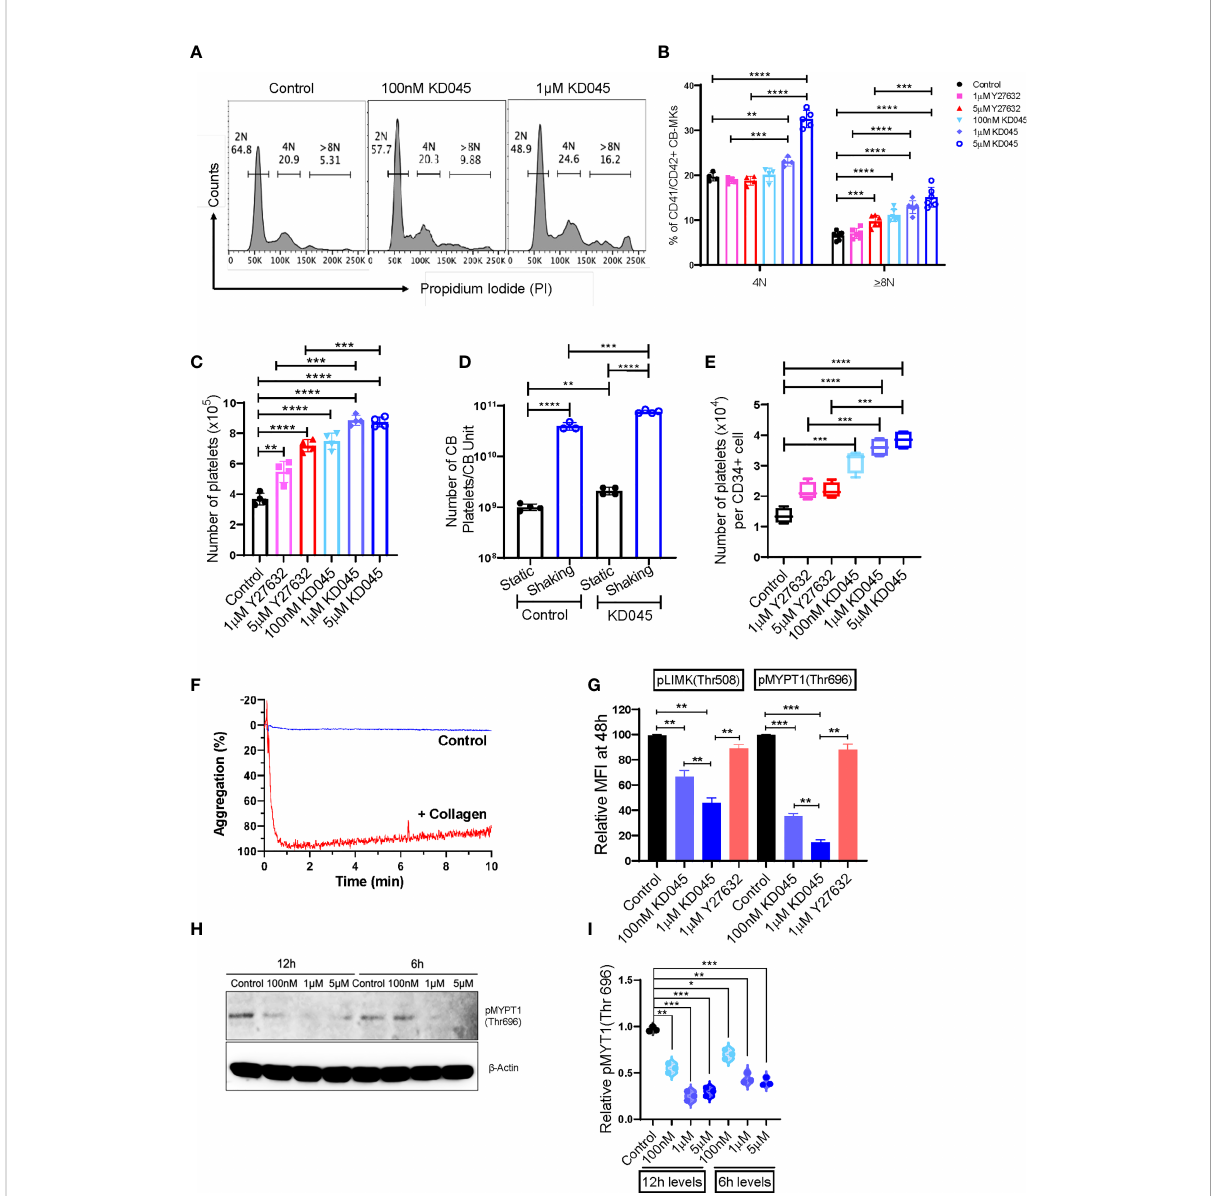
FIGURE 3 KD045 ex-vivo treatment enhances CB-MK polyploidization, reduces ROCK signaling, and stimulates MKs to secrete more functional platelets. (A) Histograms showing ploidy analysis by propidium iodide (PI) staining in CD42a+ MKs cultured alone (control) or with 100nM or 1 m M KD045 for 96h. (B) Percentages of polyploid levels in MKs that were untreated or treated for 96h with Y27632 or KD045 (n=4-6 different cords in at least 3 independent experiments, **p < 0.01, ***p < 0.001 and ****p < 0.0001). (C) Numbers of secreted platelets from 1x10 5 CB-MKs that were untreated or treated with Y27632 or KD045 (n=4 different cords in independent experiments, **p < 0.01, ***p < 0.001 and ****p < 0.0001). (D) Number of platelets generated from untreated and KD045-treated day 22 CB-MKs that were subjected to horizontal shaking for 6h prior to platelet quanti fi cation. Data are presented as the number of platelets produced per CB unit (n=3-4 per group, **p < 0.01, ***p < 0.001, ****p < 0.0001). (E) Number of platelets generated from untreated, Y27632-, and KD045-treated day 22 CB-MKs that were subjected to horizontal shaking for 6h prior to platelet quanti fi cation. Data are presented as the number of platelets generated per seeded CD34+ cell on day 0 (n=4 per group, **p < 0.01, ***p < 0.001, ****p < 0.0001). (F) Aggregation of unstimulated and collagen-stimulated platelets derived from 100nM KD045-treated CB-MKs. (G) Flow cytometry-based pLIMK(Thr508) and pMYPT1(Thr696) intracellular expression, by mean fl uorescence intensity (MFI), in untreated, 1 m M Y27632, and 100nM-1 m M KD045 treated MKs for 48h (n=3, **p < 0.01 and ***p < 0.001 by paired t-tests). (H, I) Western blots and normalized relative pMYPT1(Thr696) levels after 6h and 12h treatment with 100nM, 1 m M and 5µM of KD045 in day 22 expanded CB-MKs (n=3 independent experiments, *p < 0.05, **p < 0.01, ***p < 0.001 by paired t-tests). All statistical analyses completed with unpaired t-tests unless otherwise